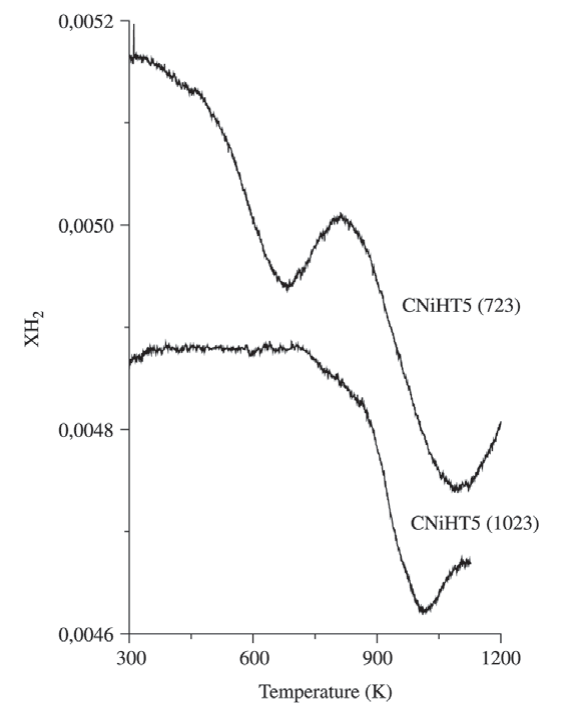
Figure 6. Thermoprogrammed reduction profile for NiHT5 cal- cined at 723 and 1023 K (TPR in the range of 298 to 1123 K, without the isothermic step at 1123 K for 2